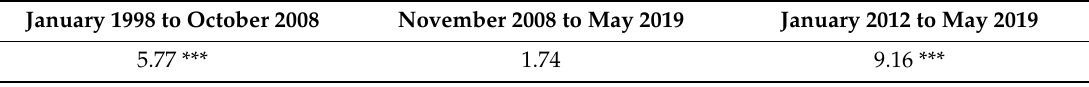
Table 11. F-bounds